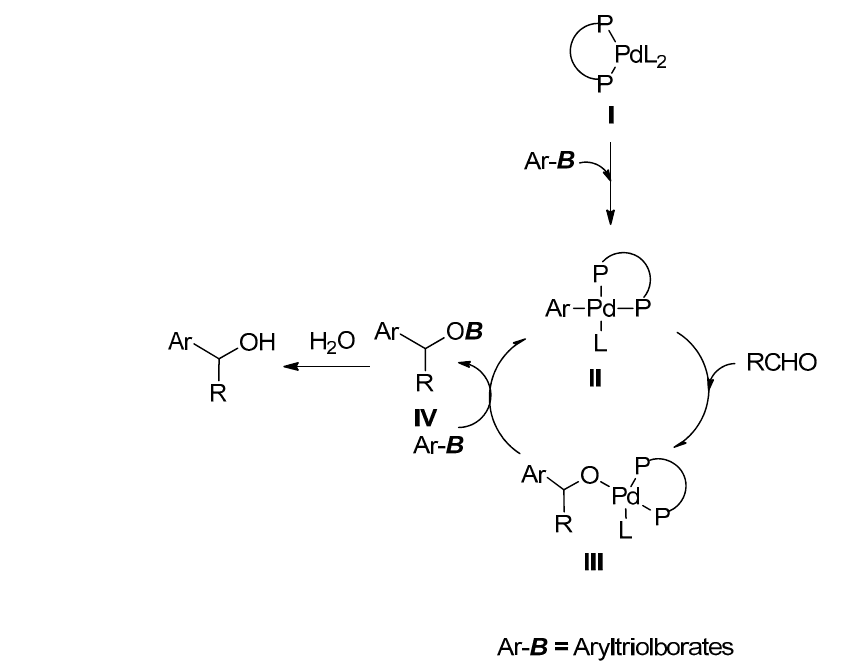
Scheme 3. Tentative mechanism for the formation of carbinol.